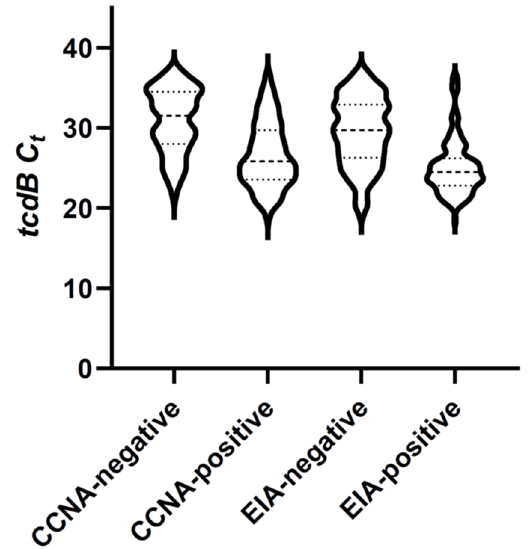
Figure 1. Box and violin plot shows distributions of tcdB C t values according to toxin test results. Minimum, maximum, median (large dashed line), and 25th and 75th percentiles (small dashed lines) are indicated. Observed frequencies of values are represented by width of the plot interval.